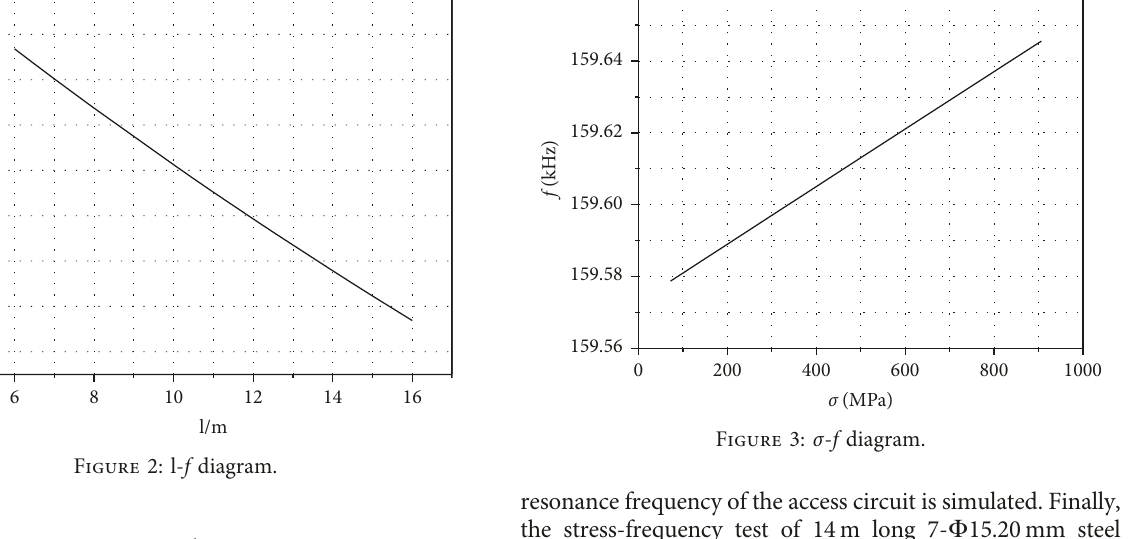
Figure 2: l- f diagram.